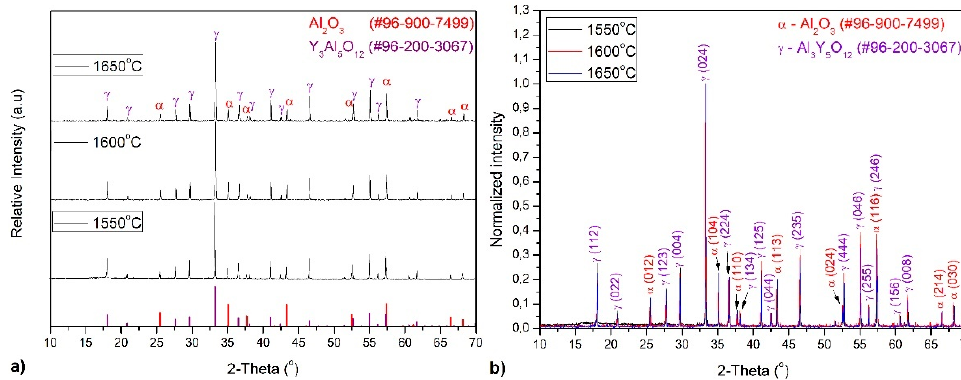
Figure 6. ( a ) XRD patterns of the Al 2 O 3 –YAG sintered samples at different sintering temperatures (1550 °C, 1600 °C and 1650 °C for 2 h holding time); ( b ) description of the crystallographic planes of the Al 2 O 3 and Y 3 Al 5 O 12 phases.